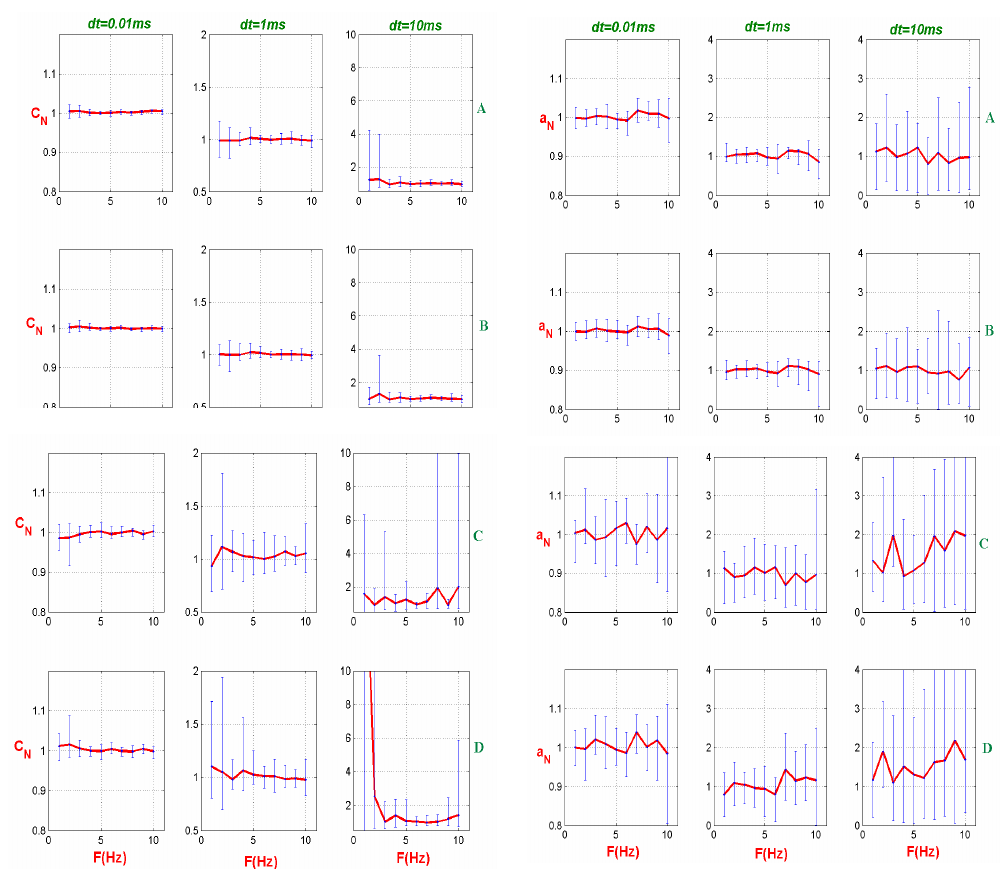
Fig.9 Frequency patterns of normalized attenuation at three different sampling interval ( dt =10ms, dt =1ms and dt =0.01ms). Data point are the mean and bars standard error of ten noise